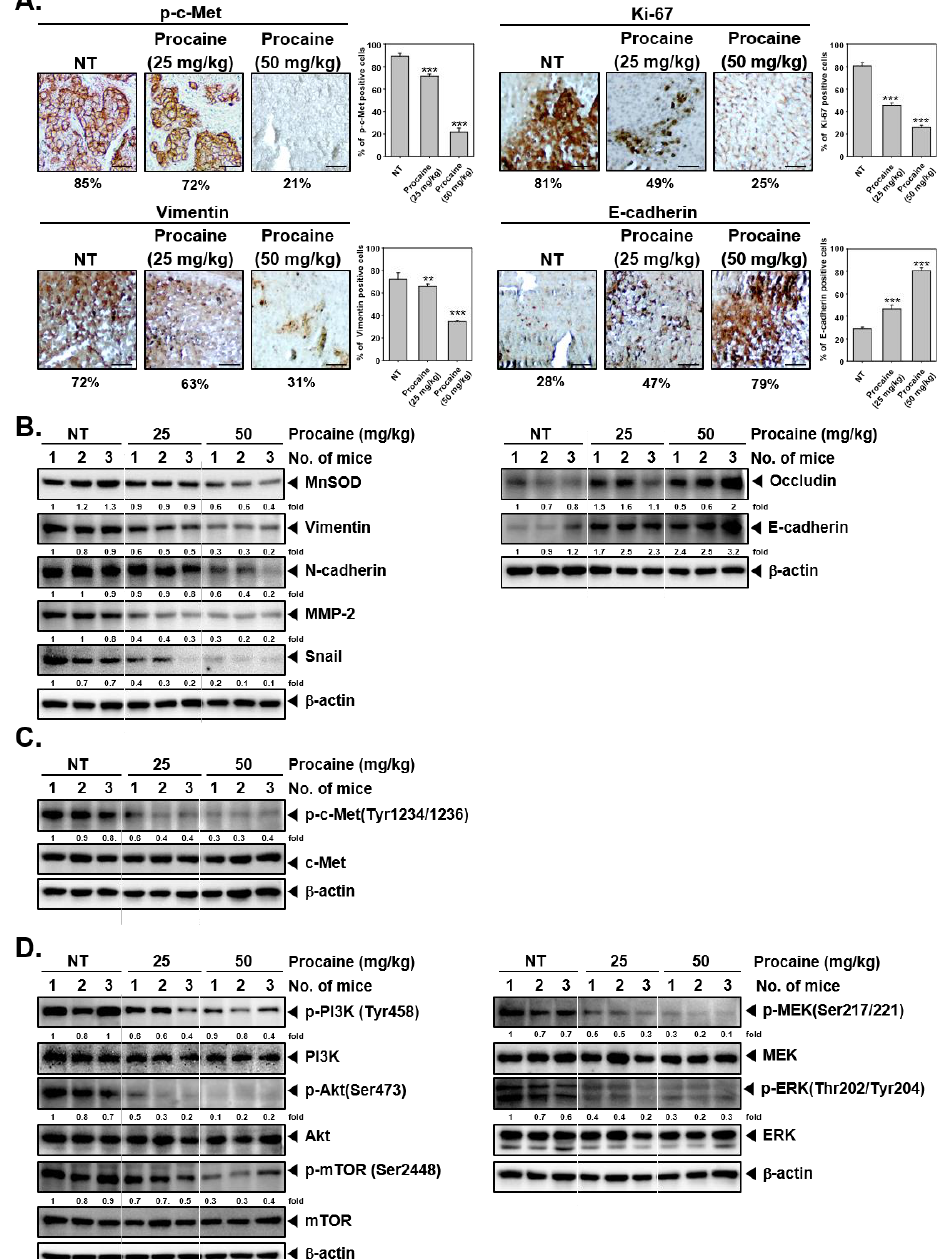
Figure 5. Impact of procaine on EMT and c-Met dependent signaling cascades in tumor tissues. ( A ) Examination of EMT markers and phospho-c-Met by IHC. The expression of phospho-c-Met, Ki-67, Vimentin, and E- cadherin was quantified and represented as mean ± SD on the right panel (scale bar: 200X). ** p < 0.01 vs. non-treated (NT) cells and *** p < 0.001 vs. non-treated (NT) cells. ( B ) The expression of EMT markers is analyzed using western blot analysis. ( C , D ) The expression of p-c- Met (Tyr1234/1236), c-Met, p-PI3K (Tyr458), PI3K, p-Akt (Ser473), Akt, p-mTOR (Ser2448), mTOR, p-MEK (Ser217/221), MEK, p-ERK (Thr202/Tyr204), and ERK was checked in tumor tissues.